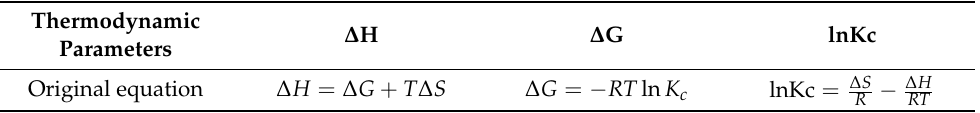
Table 12. Thermodynamic equation.